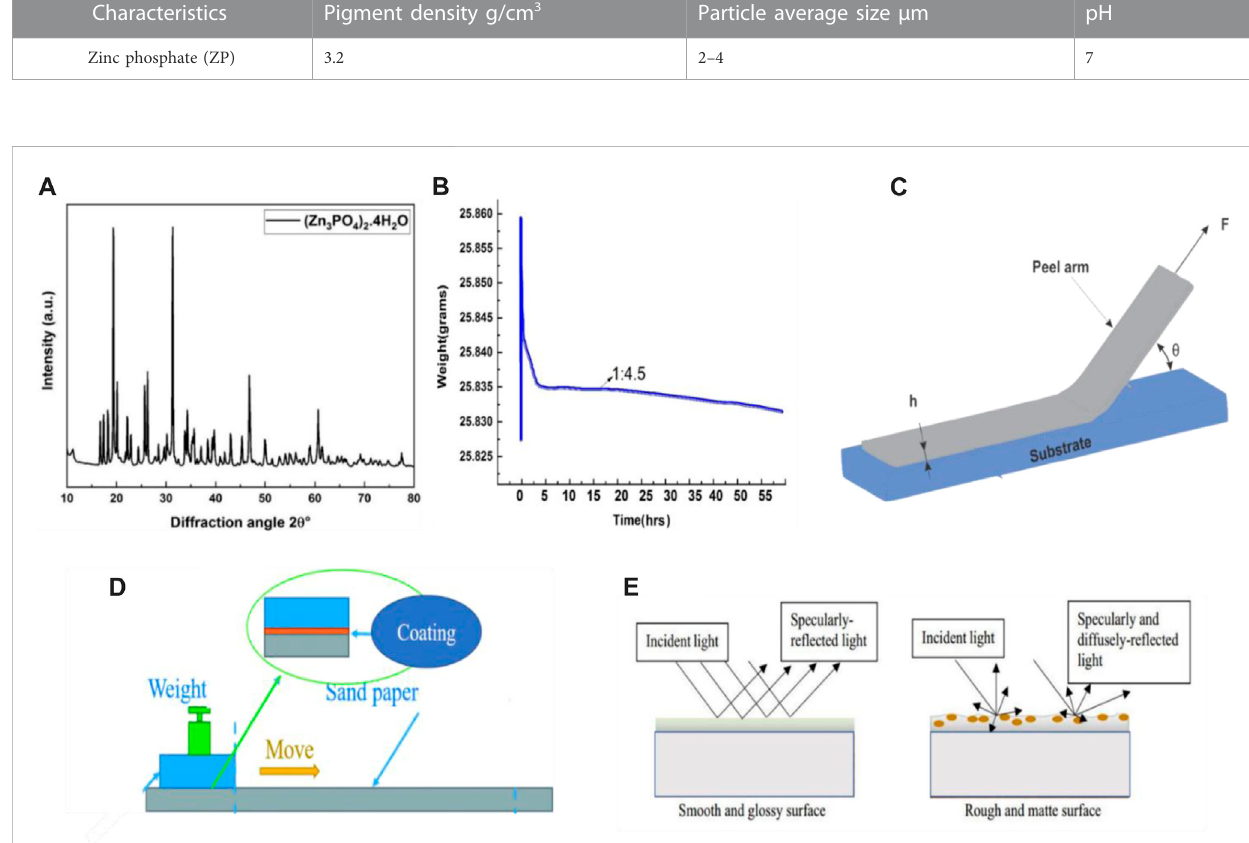
FIGURE 2 2 (A) X-raydiffractionofZPpigment,2 (B) typicalevaporationprocessofcoatedsamplewithratio ofepoxy tosolvent of1:4.5,2 (C) peeling offmodel of a fi lm with adhesion length l in contact with a substrate, 2 (D) 5 schematic diagram of the scratch test and 2 (E) schematic presentation mechanism of light interaction on the smooth and rough